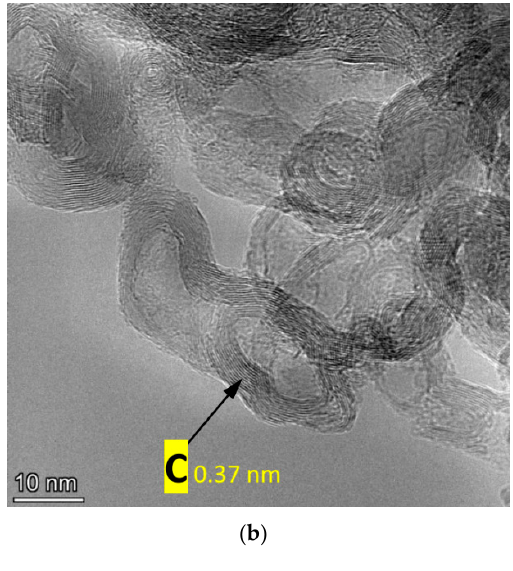
Figure 1. Powder XRD patterns of the prepared catalysts. Though Co@NC-Gr and Co@NC-ZIF catalysts are obtained by different synthetic approaches, their TEM images look very similar except a higher proportion of cobalt nanoparticles in the latter sample (Figures S1 and S2, Supplementary Materials). The nanoparticles observed are mainly 10 ÷ 30 nm size for both the catalysts, in accordance with our previous results [36,37]). Despite being enveloped by graphitic carbon, the me- tallic cobalt particles practically disappeared after treatment of Co@NC-Gr with sulfuric acid (Figure S3). In contrast, Co@NC-ZIF SA retained some parts of cobalt nanoparticles if they were in dense graphite packaging (Figure 2a,c). In addition, well-resolved fragments of CoO x are present in the catalyst (Figure 2d). That is also confirmed by EDX-STEM mapping images of Co@NC-ZIF SA , where location of cobalt and oxygen conglomerates definitely coincides in some cases (Figure 3a–c). Figure 3d–f demonstrates STEM images of another fragment of the same sample, il- lustrating a uniform distribution of subnanosized Co species and nitrogen in carbon. Ac- cording to EDX analysis, the atomic fraction of Co in this area is only 0.27% (1.33 wt.%), while the atomic and mass fractions of nitrogen are 2.32 and 2.66%, respectively (Figure S4). The subnanosized cobalt can be assumed to exist mainly in the form of a single-atom sites coordinated to nitrogen atoms (cf. [34–36]). The estimated Co fraction is certainly less than that in an area of Co@NC-ZIF SA , containing Co/CoO x nanoparticles (~6 wt.%, Figure S5), and well below of the average Co content determined by XRF technique (Table 1).